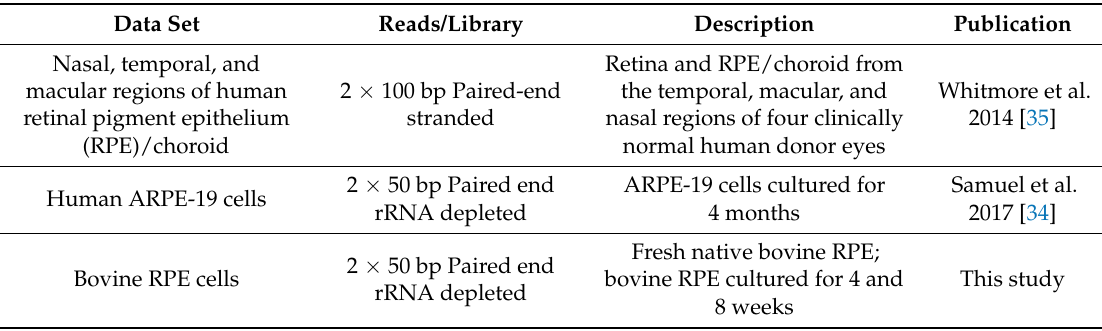
Table 1. RNA-seq